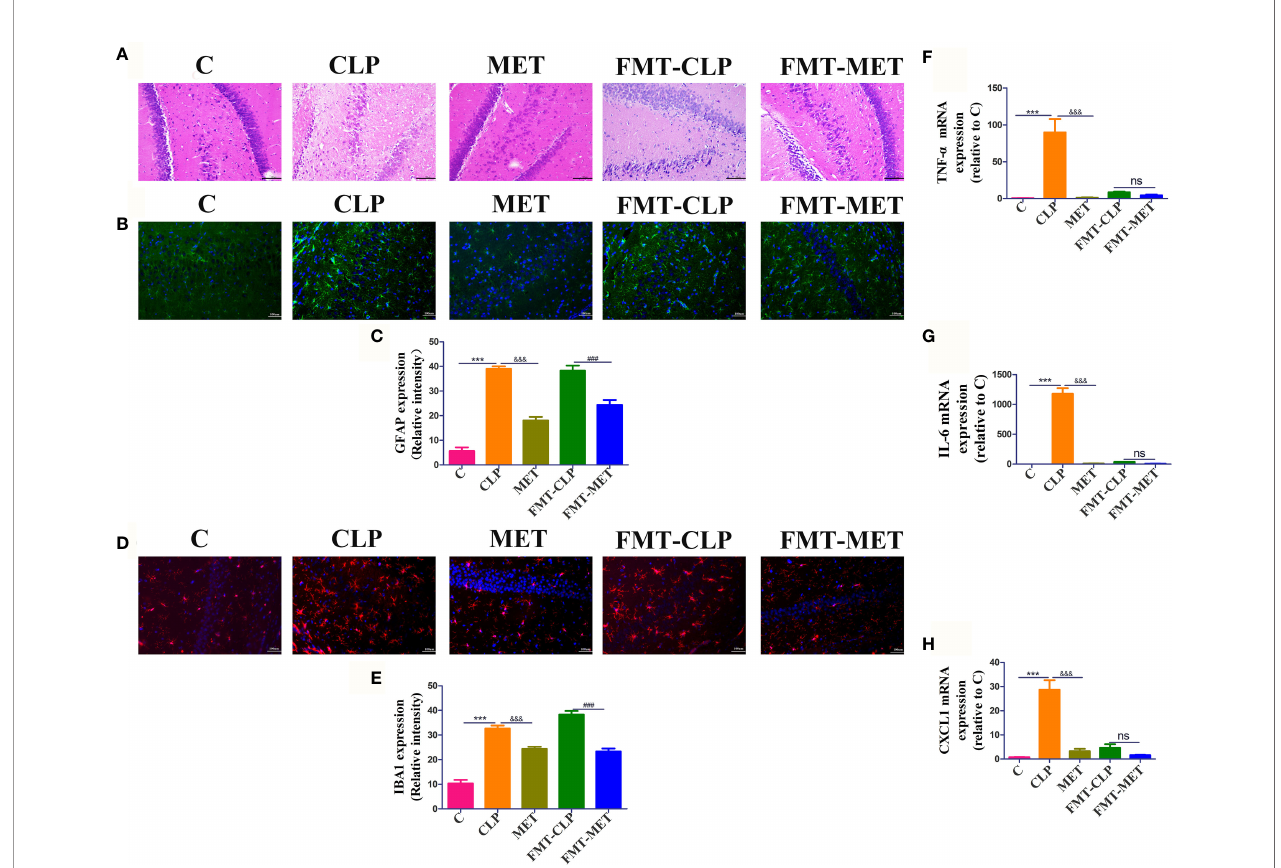
FIGURE 1 | Metformin mitigates sepsis-related neuroin fl ammation and injury in septic rats. (A) H&E staining showed a large number of nerve cells with nuclear pyknosis, disordered structural arrangement, edema of nerve cells, and serious injury in CLP group compared with the C group; metformin administration reversed the CLP-induced serious brain injury compared to the septic rats. It showed a decreased level of the in fl ammatory in fi ltrates, oedema, and haemorrhage of brain tissue in the FMT-MET group compared to the FMT-CLP group (scale bar = 100 um). (B – E) The immuno fl uorescence experiments indicated that the iBA1 and GFAP expression increased signi fi cantly in septic rats compared to the C group rats, whereas metformin administration and metformin-treated FMT assay showed signi fi cantly decreased iBA1 and GFAP expression (scale bar = 100 um). (F – H) The expressions of TNF- a , IL-6, and CXCL1 increased drastically in the CLP group than the MET group. * CLP vs C group; & MET vs CLP group; : FMT-MET vs FMT-CLP group, ***, ###, &&& P <0.001; ns: not signi fi cant ( n = 3 –